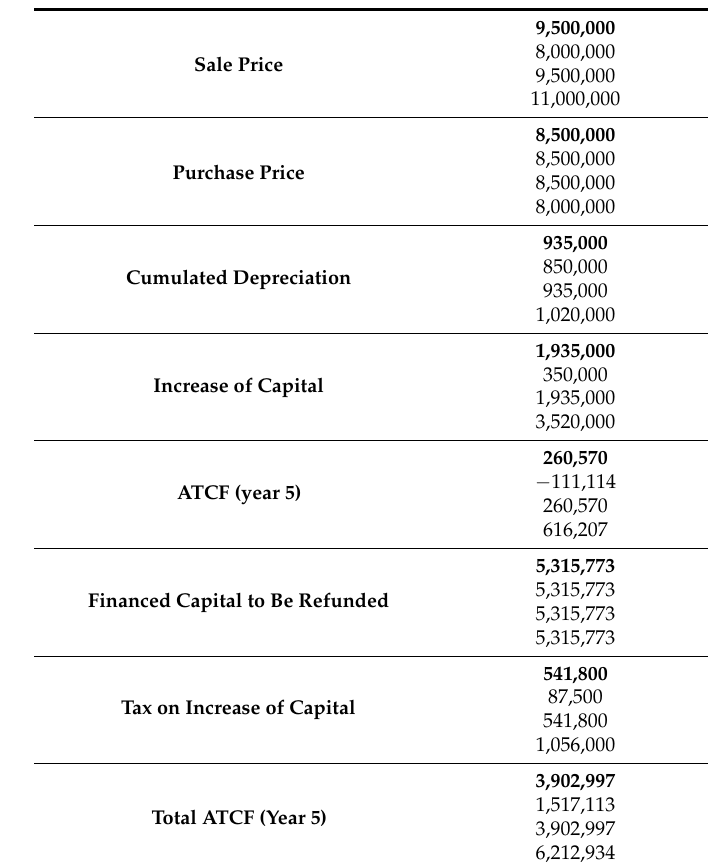
Table 12. Cash flow in the fifth year relative to the sale property.